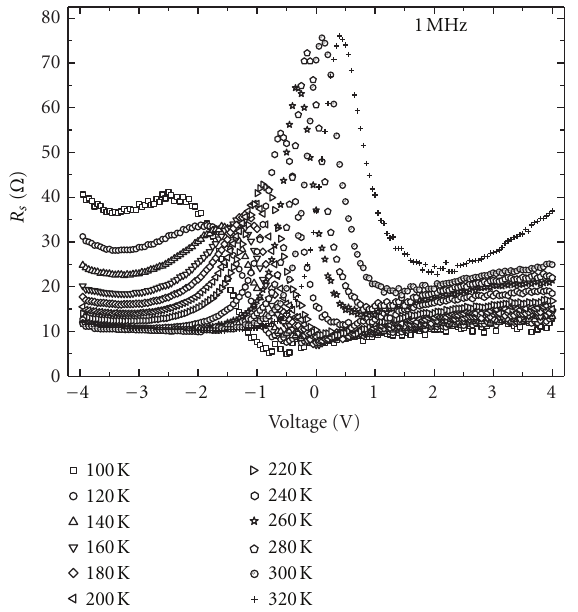
Figure 9: The variation of the series resistance of the Al/HfO 2 /p- Si (MOS) structure as a function of the bias voltage for various temperatures.